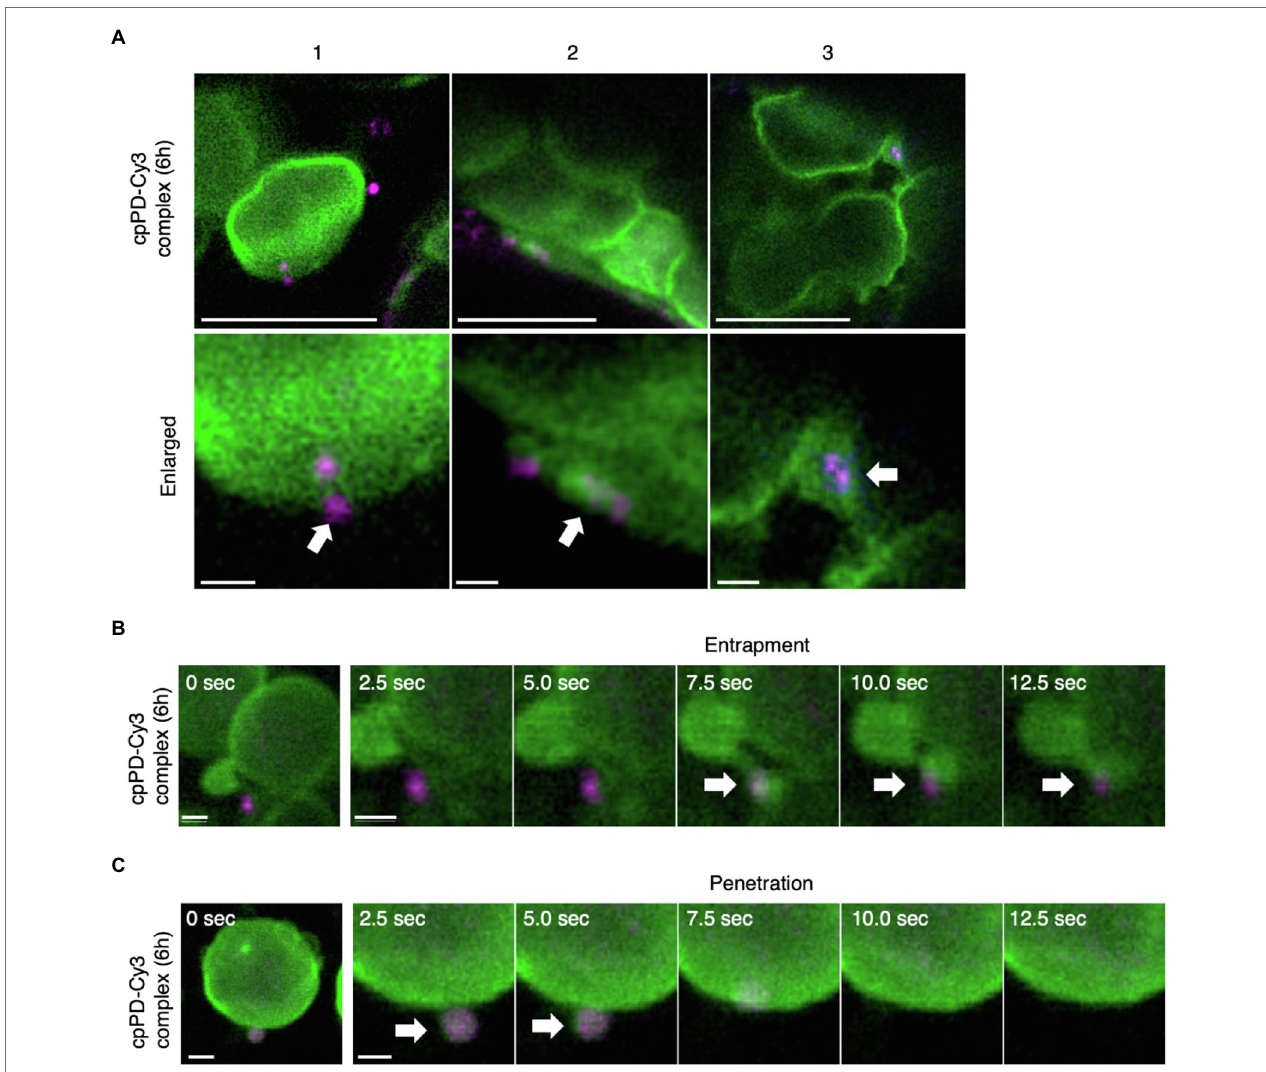
FIGURE 4 | KH-AtOEP34–pDNA complexes localize to the chloroplast outer membrane. (A) Three representative examples (1–3) of KH-AtOEP34–pDNA localization patterns, as visualized by Cy3 fluorescence (cpPD-Cy3; magenta) around chloroplasts (green). Bars = 5 μ m. Enlarged images in the lower panels represent cpPD-Cy3 complexes associated with (1) , being enveloped by (2) , or integrated into (3) , the chloroplast outer membrane (green). Arrows denote cpPD- Cy3 complexes. Bars = 1 μ m. (B,C) Time-lapse images illustrating entrapment (B) and incorporation (C) of cpPD-Cy3 complexes by the chloroplast outer